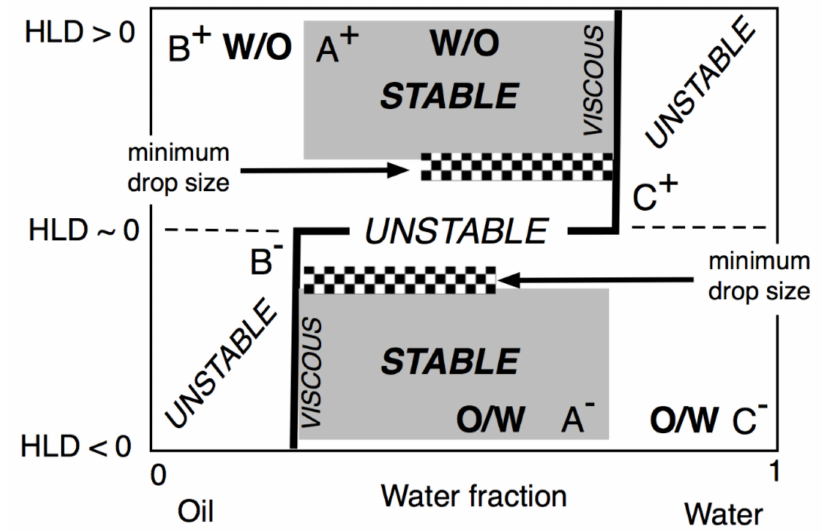
Figure 17. Classical formulation-composition diagram (HLD-WOR) showing the basic properties (stability, drop size and viscosity) as described a long time ago